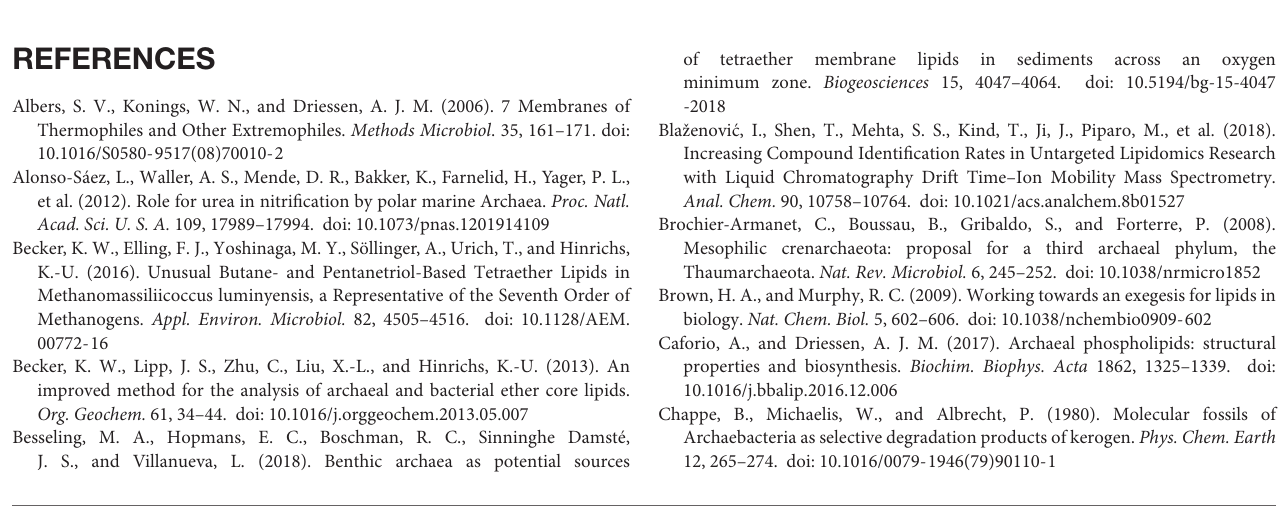
Supplementary Table 1 | List of detected lipids and their CCS